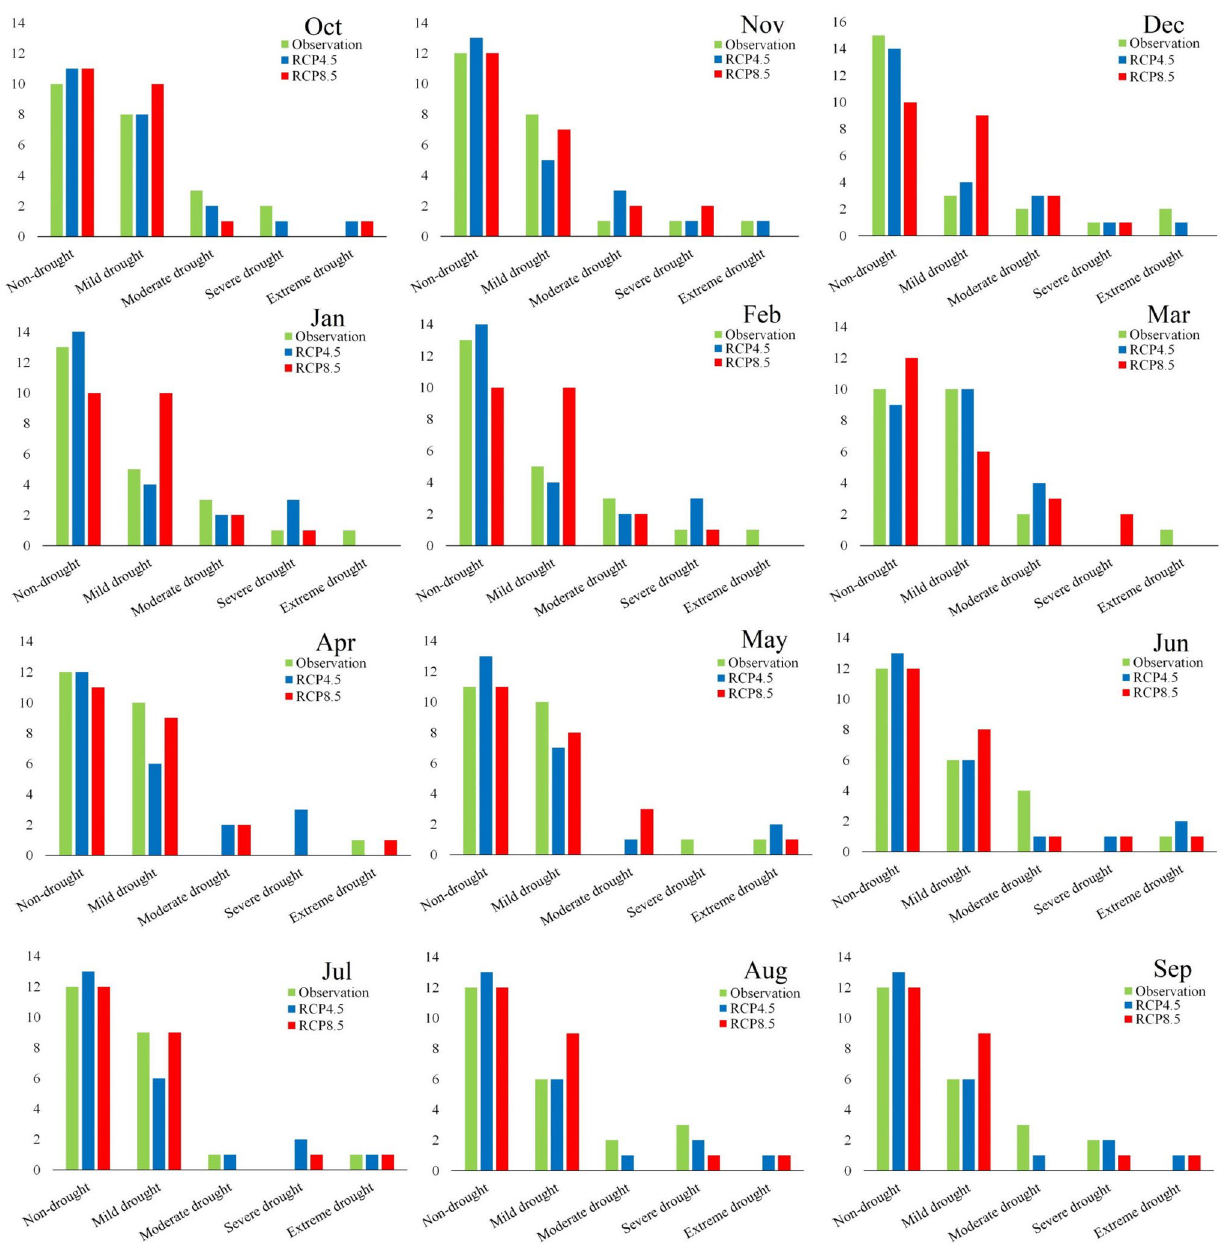
Fig. 19 Monthly Streamflow Drought Index (SDI) in the baseline and future periods under scenarios (RCP4.5 and